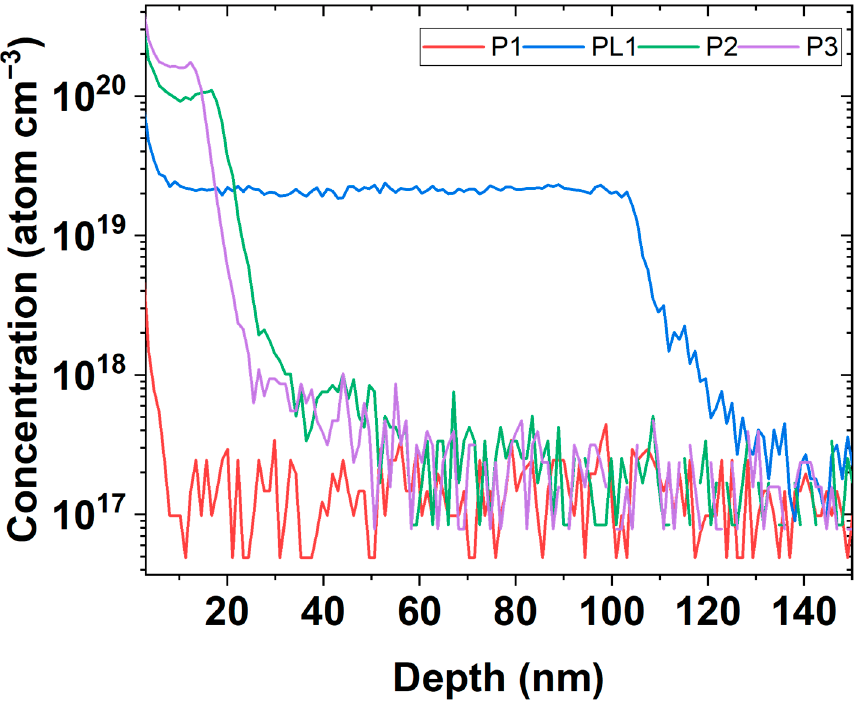
Figure 5. SIMS of the P-doped DSUTF samples.